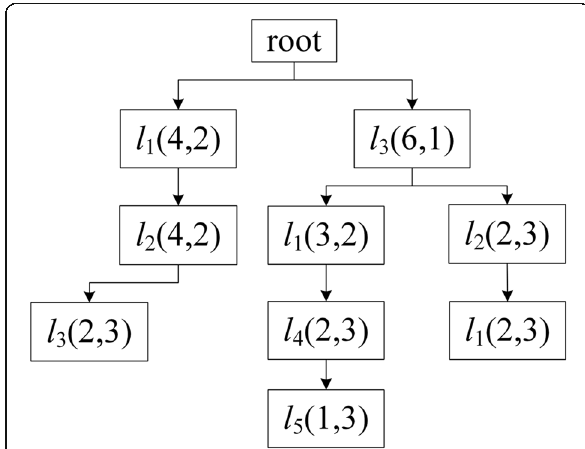
Fig. 4 The prefix tree structure for user